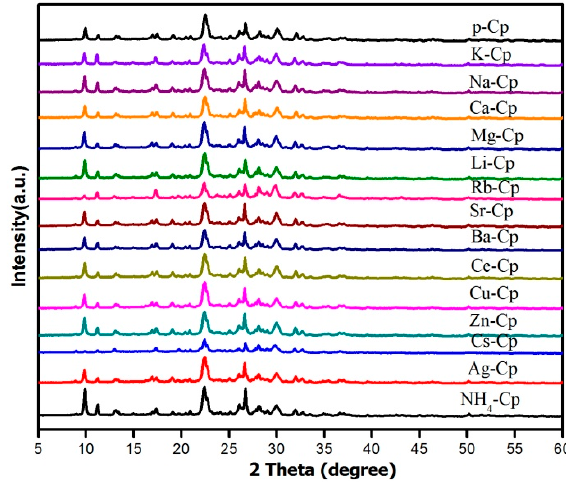
Figure 6. The XRD patterns of the modified Cp.